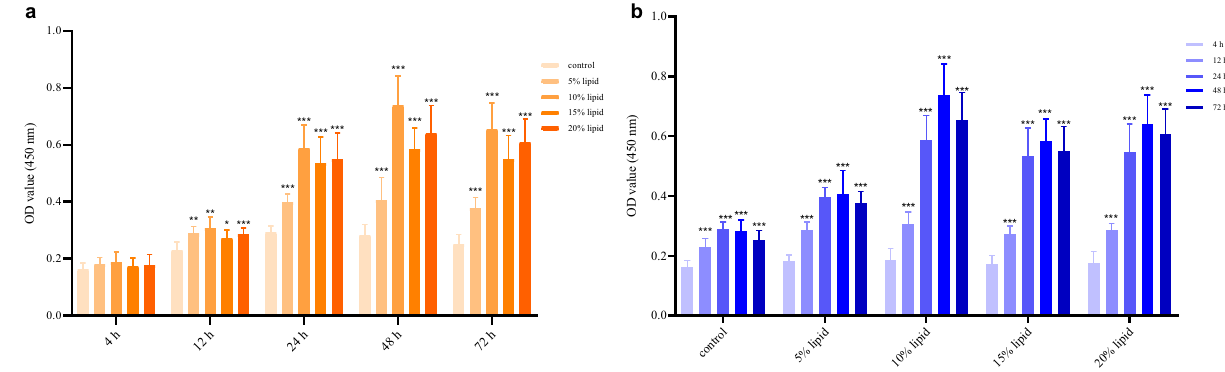
Figure 2. Effect of lipid emulsions on microbial viability in mixed-species BFs. Compared with the control group at the same time, * P < 0.05, ** P < 0.01, *** P < 0.001 ( a ). Compared with the 4 h at the same concentration, * P < 0.05, ** P < 0.01, *** P < 0.001 ( b